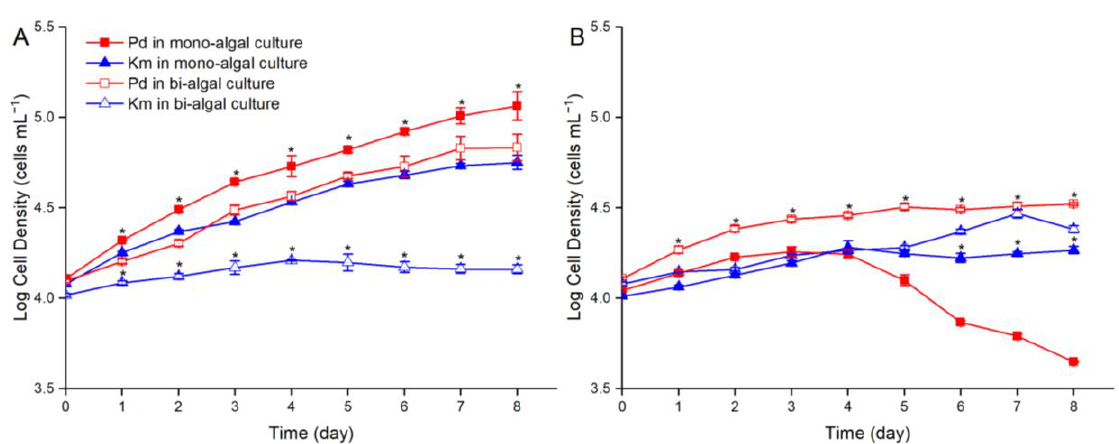
Figure 3. Growth curves of P. donghaiense and K. mikimotoi in mono- and bi-algal cultures under P-sufficient ( A )/deficient ( B ) conditions. The values are the mean ± S.D. ( n = 3), with * represent significant differences ( p < 0.05) between mono-algal and bi-algal cultures.